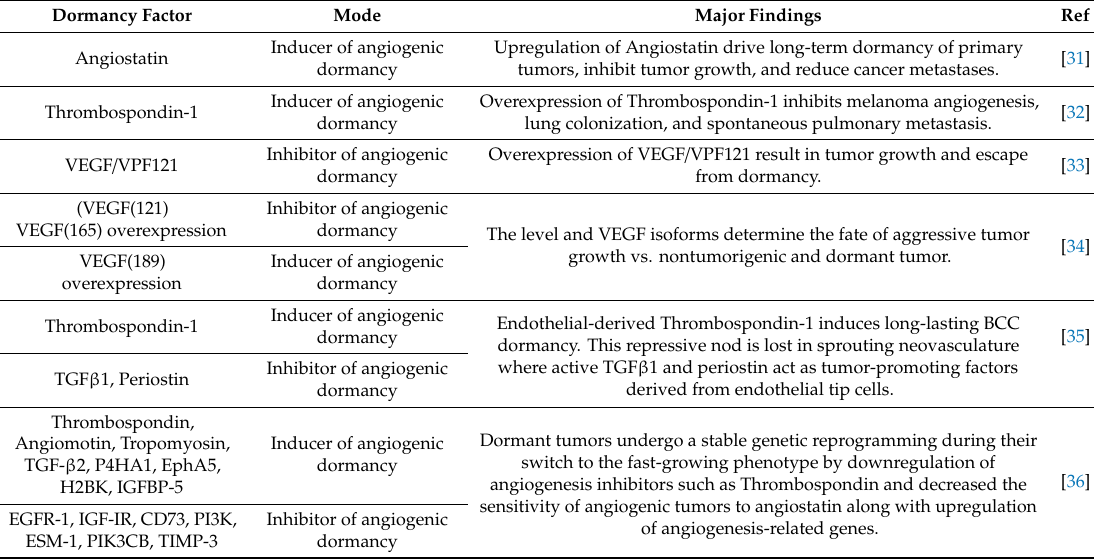
Table 1. Molecular cues involved in tumor cell